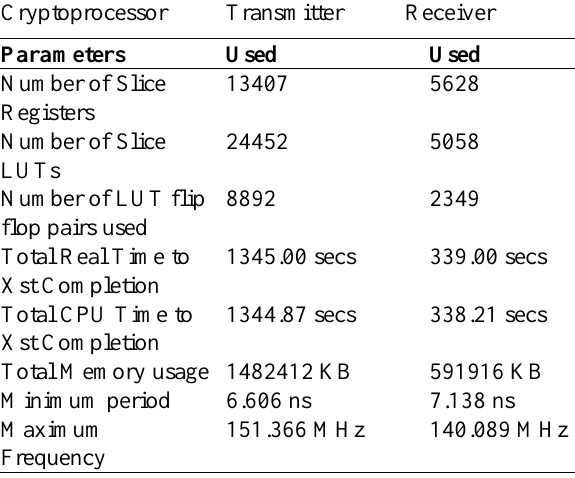
Table 1 Synthesis Summary of Cryptoprocessor